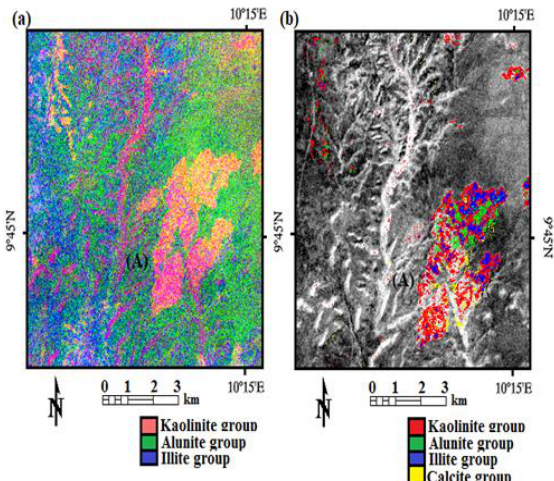
Figure 3: (a) MF score RGB for selected endmembers (ASTER) showing incoherent image with errors. (b) MTMF subpixel